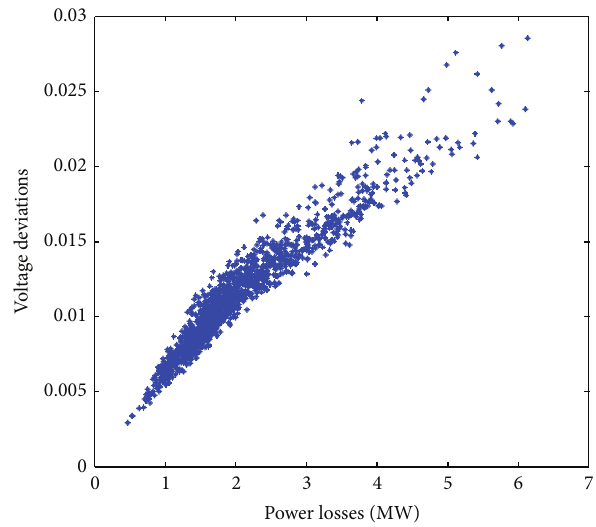
Figure 9: Solutions in the search space for optimizing power losses and voltage deviations. Table 2: Characteristics of the approximate Pareto-optimal solu- tions in Figure